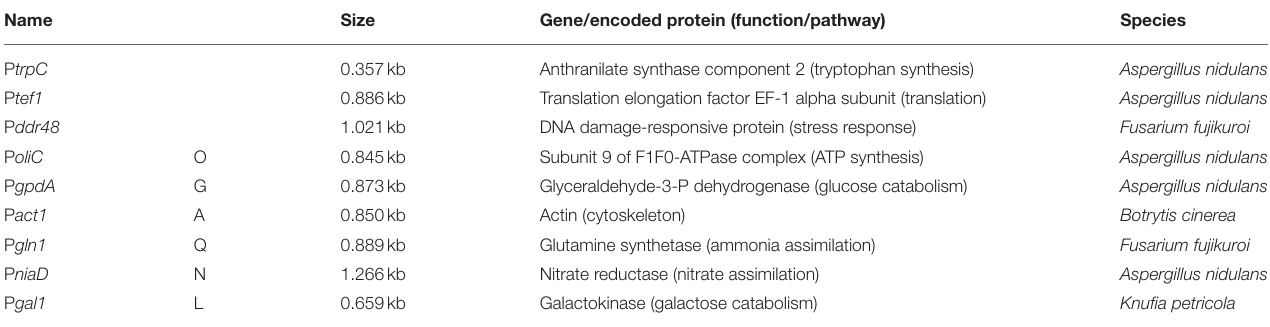
TABLE 3 | Heterologous promoters used and/or tested in K. petricola .